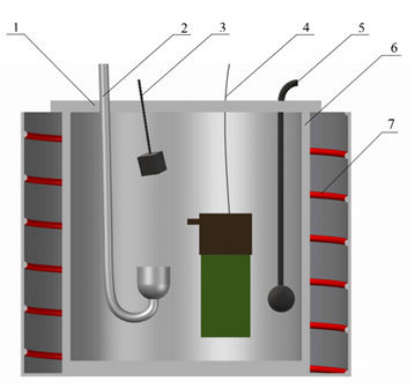
Figure 2. Technical illustration through a cross-section of an example PBR: (1) reactor cover, (2) di ff user feeding system, (3) temperature sensor PT100, (4) circulating pump Eden 128, (5) PAR probe, (6) glass reactor, (7) cylindrical LED light jacket. Source: own